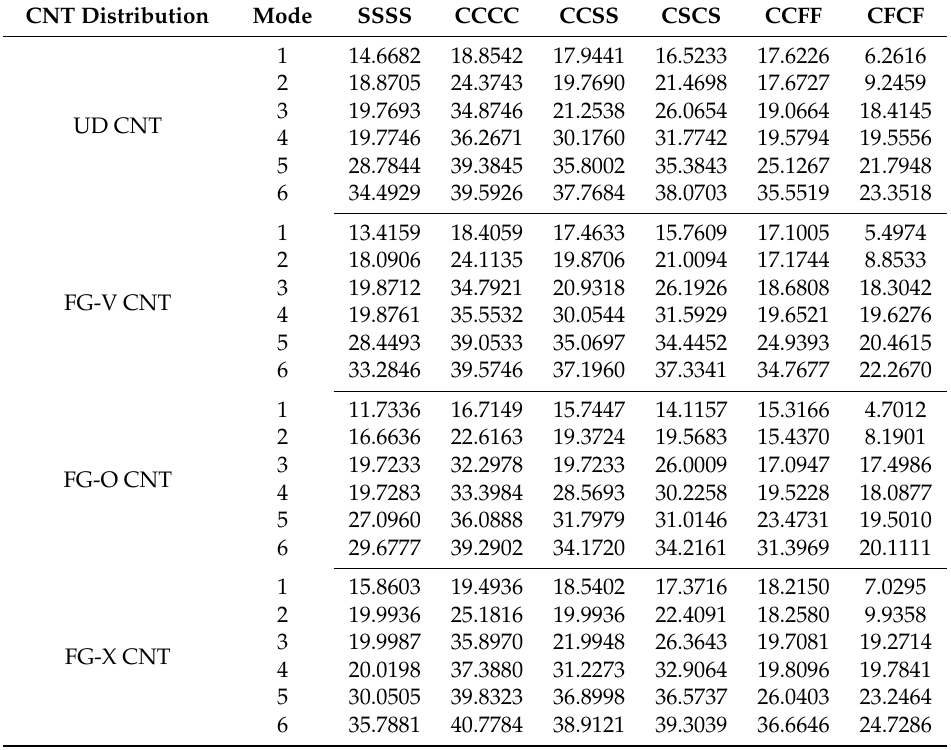
(cid:0) = 0.14, a / h = 10 (cid:1) V ∗ CNT